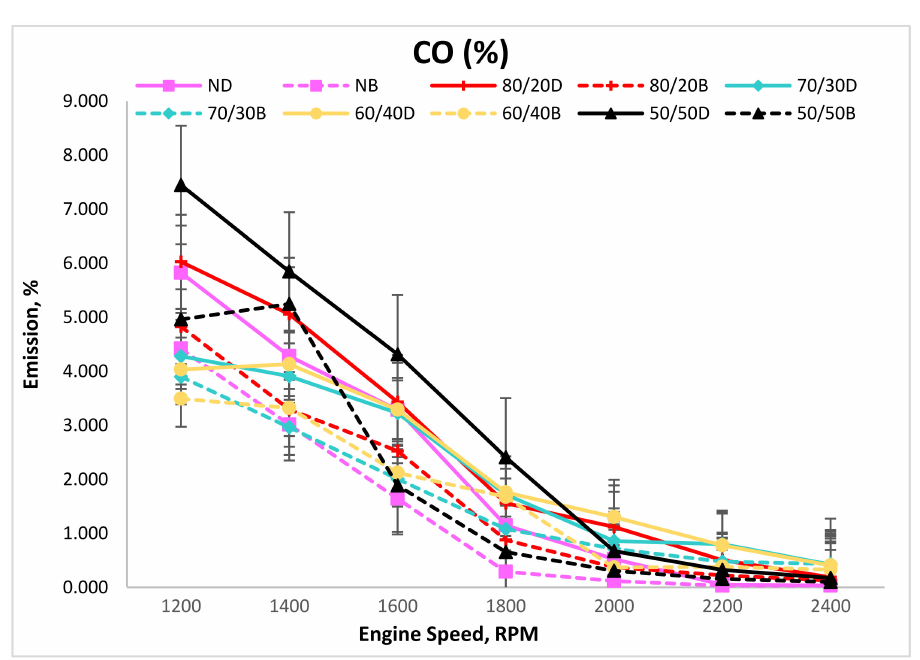
Figure 7. CO emission. 60/40D with 4.034% indicates lowest amount release of CO, followed by 70/30D; 4.277%, 80/20D; 6.024%, 50/50D; 7.446%. Then, for the biodiesel, 60/40B released